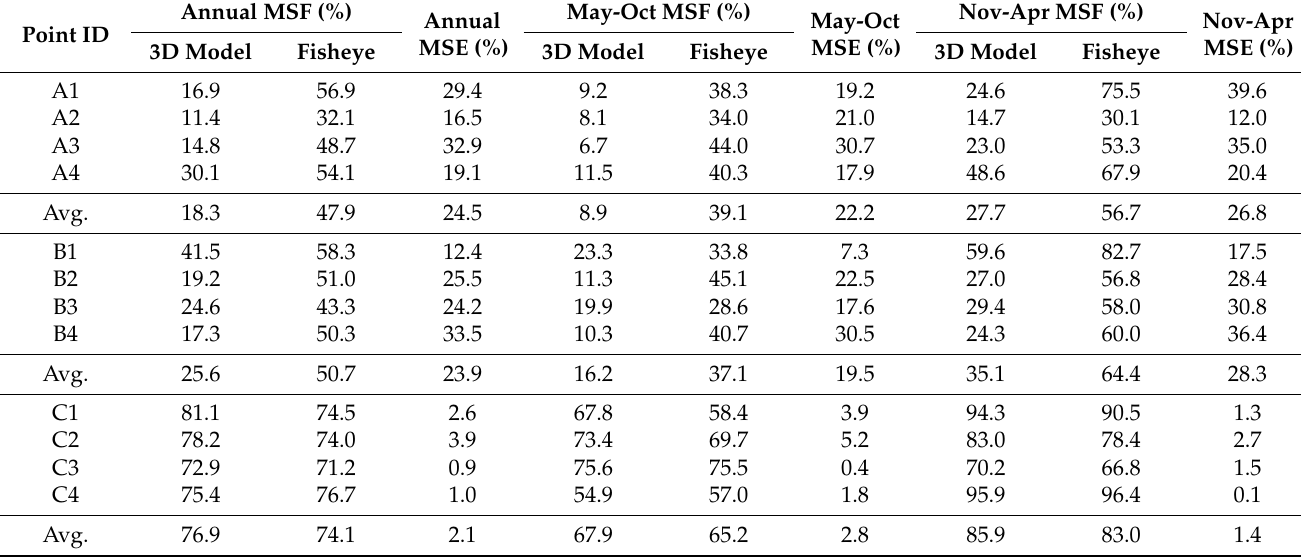
Table 5. Mean shading factors over one year, in May – October, and in November – April at 12 survey points.